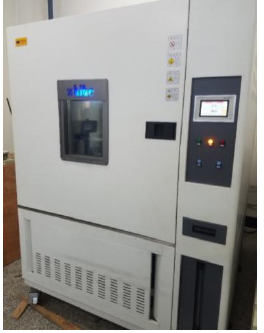
Figure 4. High – Low Temperature Experimental Box.